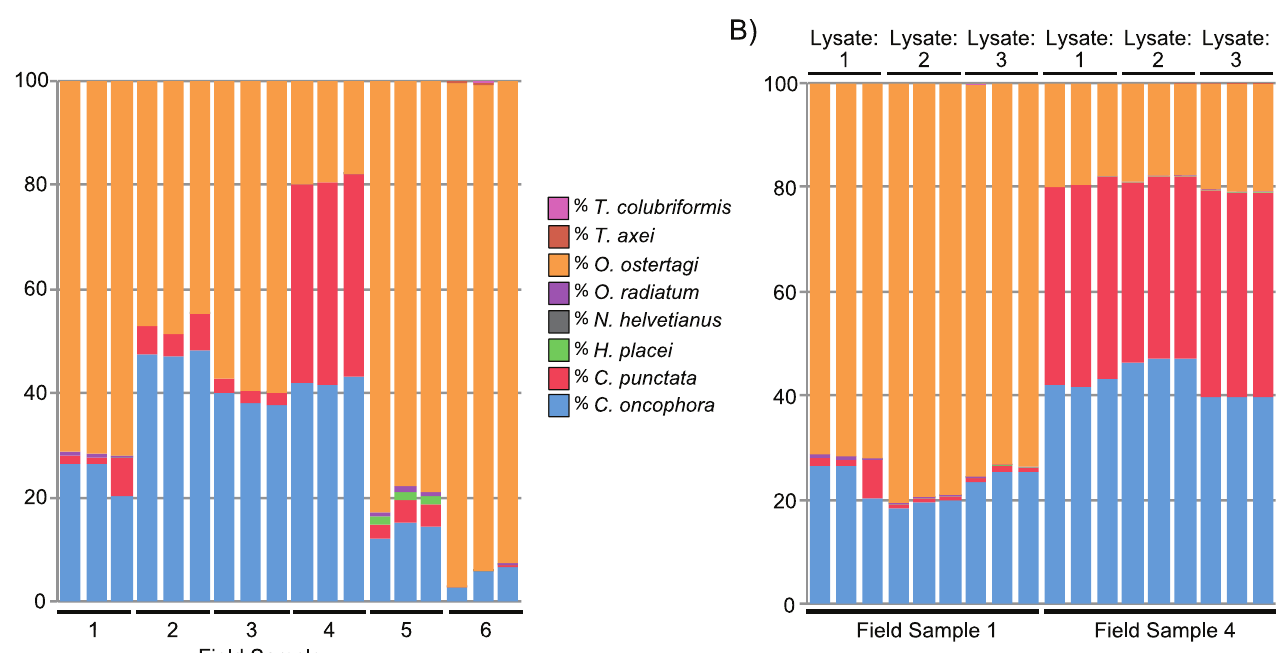
Fig 5. Repeatability of the amplicon sequencing assay when applied to field samples. The amplicon sequencing assay was applied to DNA lysates made from populations of L3 larvae collected from field samples from six Canadian cattle farms (Field samples 1 – 6). Fig 5A : The results of three technical replicates of the amplicon sequencing assay applied to the same single DNA lysate made from larval populations of each farm. Each DNA lysate was made from 300 – 2000 larvae (Field sample 1 = 1000 L3; Field sample 2 = 400 L3; Field sample 3 = 1000 L3; Field sample 4 = 2000 L3; Field sample 5 = 300 L3 and Field sample 6 = 2000 L3. Fig 5B : The results of three technical replicates of the amplicon sequencing assay applied to three independent DNA lysates made from separate batches of 1,000 and 2,000 larvae from field samples 1 and 4 respectively. The Y-axis of both charts shows the percentage species proportions as determined by the amplicon sequencing assay (25 cycles of amplification and following application of the appropriate correction factor). The field sample number is indicated on the